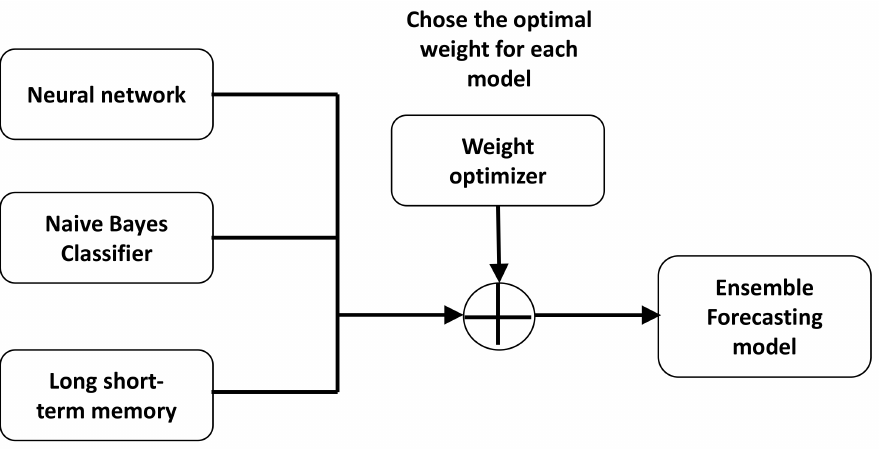
Figure 2. Configuration of an ensemble forecasting